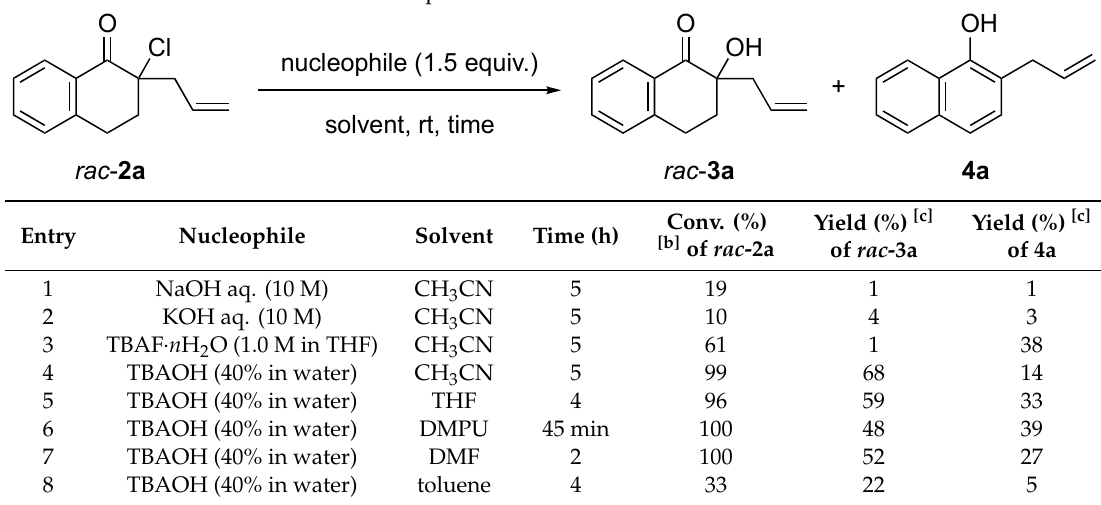
Table 1. Optimization of reaction conditions [a] .